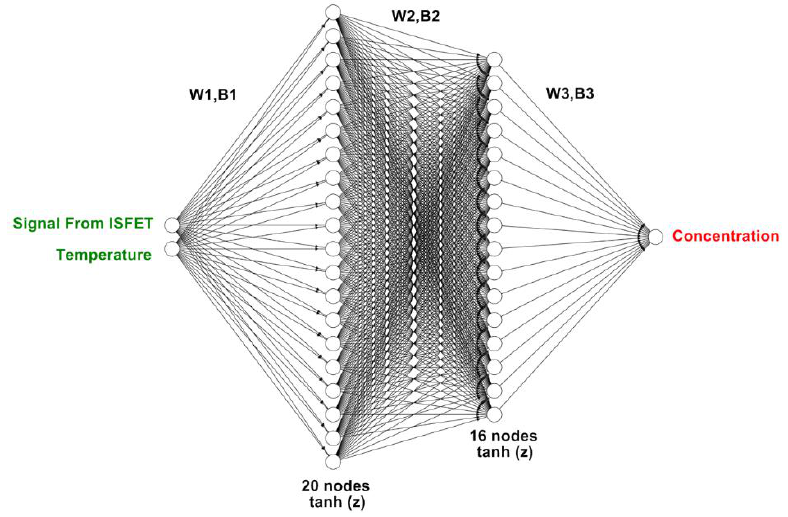
Figure 2. The multiple-input deep learning regression-based model predicts pesticide concentration based on the ISFET signal response and solution temperature.